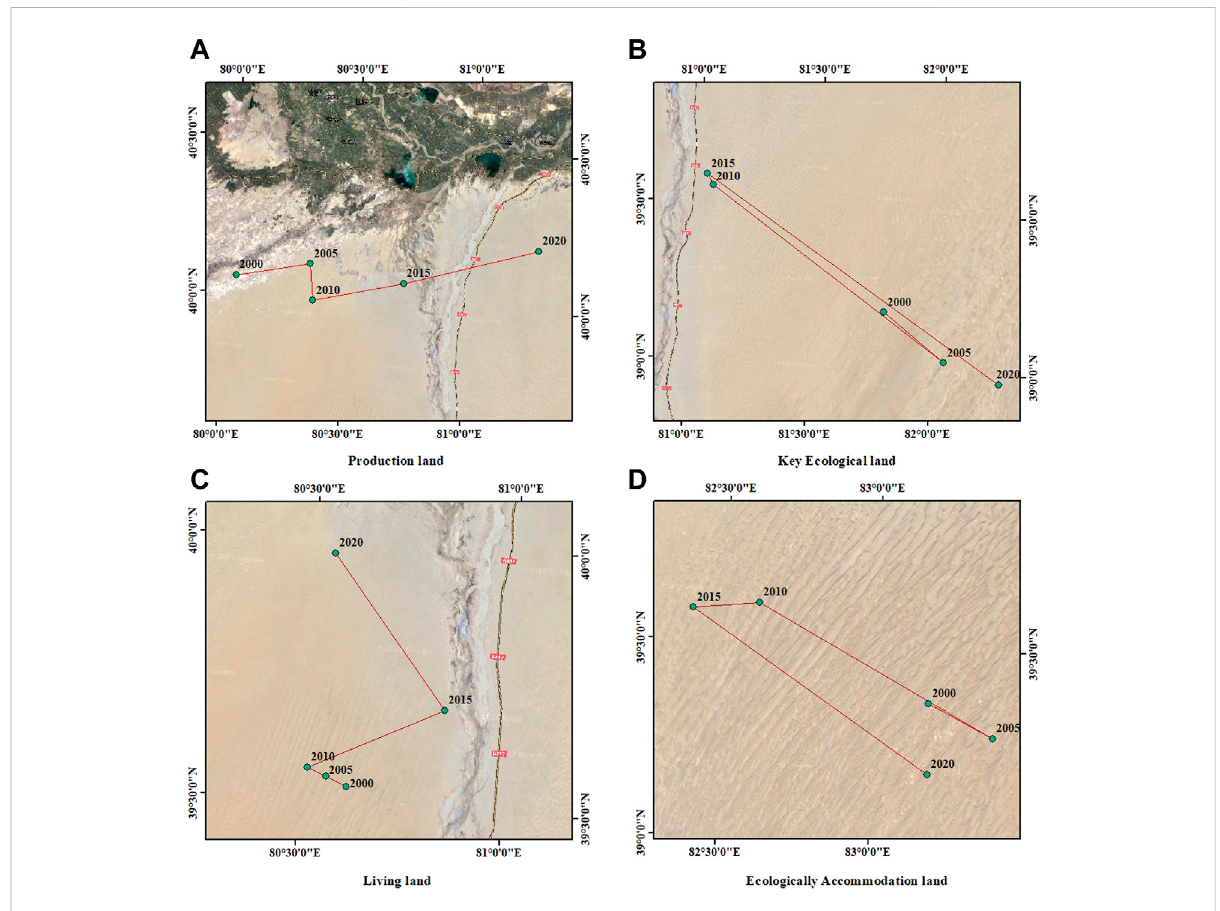
FIGURE 4 Location, shifting direction, and distance of gravity center of PLES during 2000 – 2020.